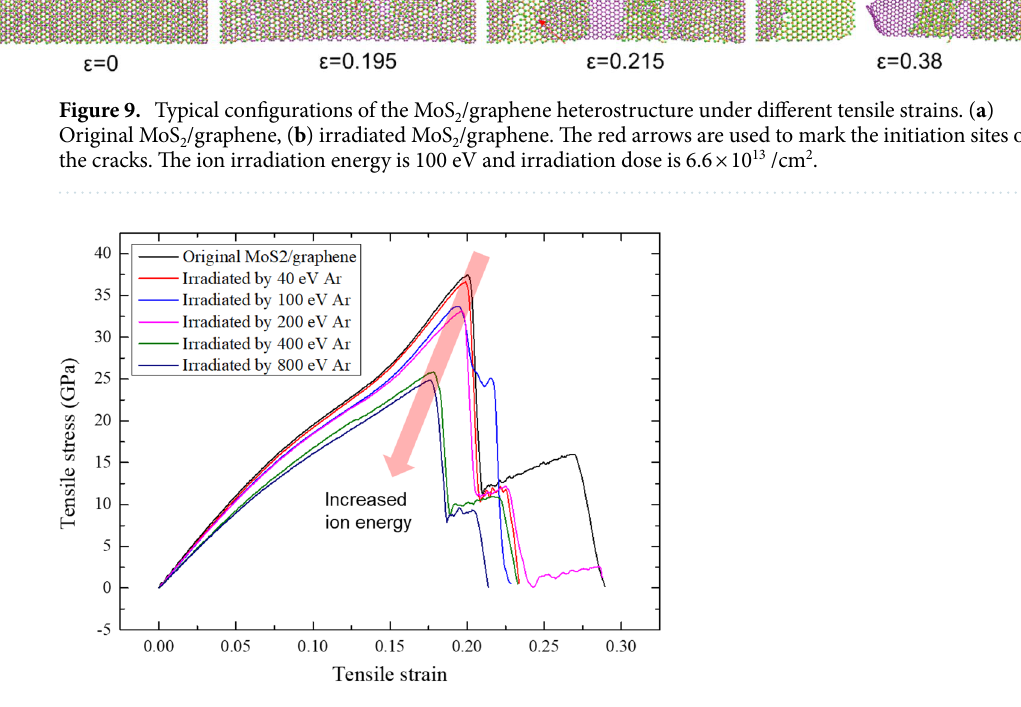
Figure 10. Tensile stress–strain curves of the MoS 2 /graphene heterostructure irradiated with different energies. Note, the stress–strain data was extracted every 500